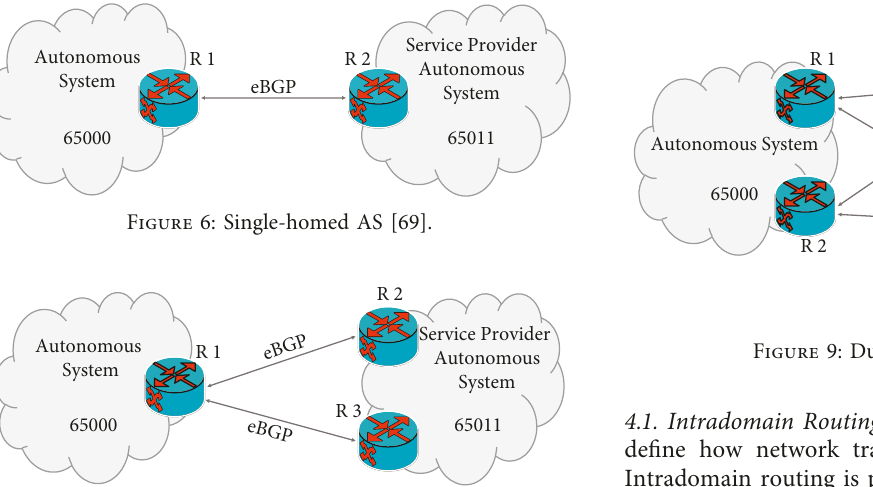
Figure 7: Dual-homed AS [69].